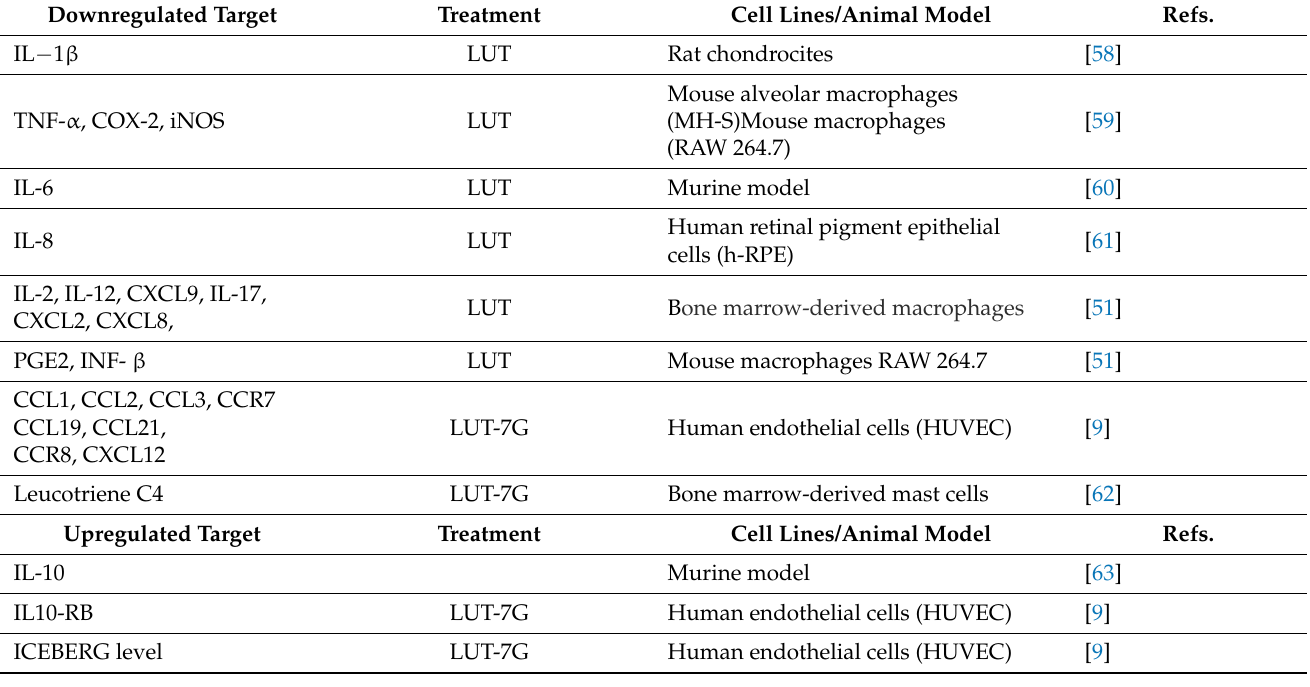
Table 6. Summary of luteolin and LUT-7G effects in regulating pro-inflammatory and anti- inflammatory mediators.